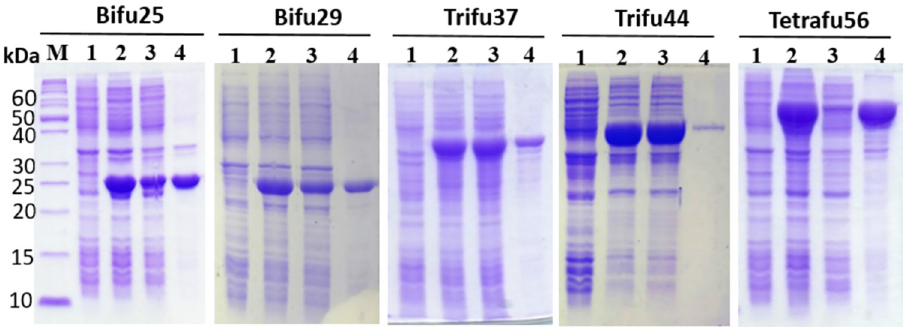
Fig 3. SDS-PAGE showing expression of bifu25 and bifu29 and the other fusion proteins. Lanes M: Protein markers; 1: Uninduced E . coli cells; 2: Lysate of the induced E . coli cells; 3: Soluble fraction of the cell lysate; 4: Insoluble fraction of the cell lysate.